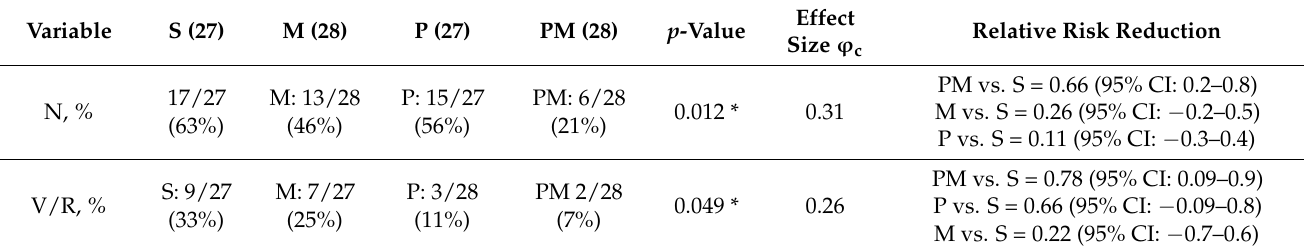
Table 4. Proportions of women presenting with nausea or vomiting.